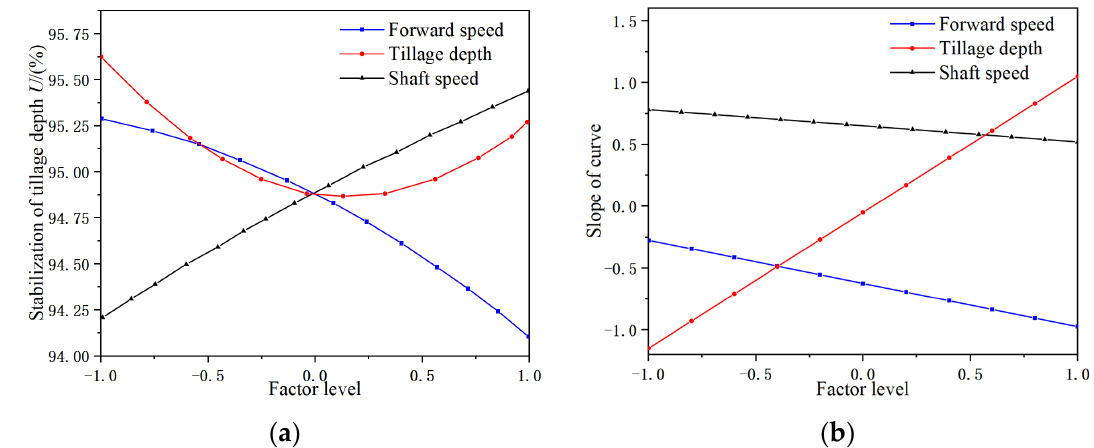
Figure 17. Single-factor effect of tillage depth stability. ( a ) Submodel regression curve; ( b ) slope of the factor curve.